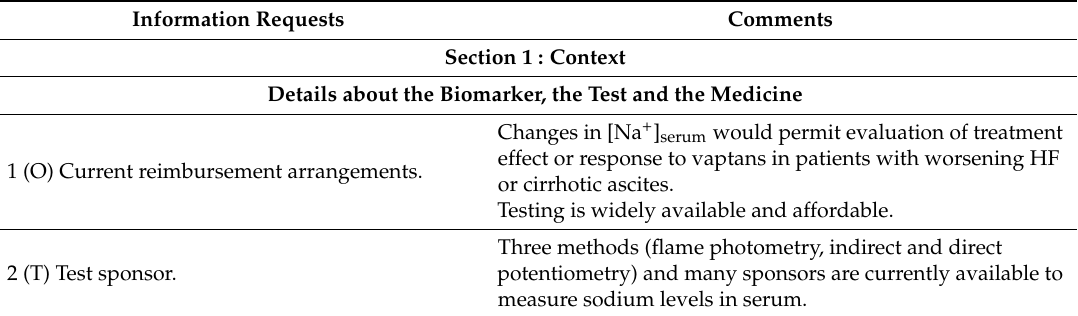
Table 3. Assessment of codependency when combining the treatment and the biomarker.